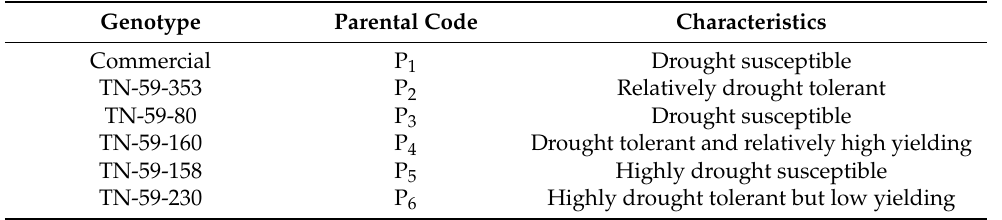
Table 4. Coriander genotypes and their characteristics.